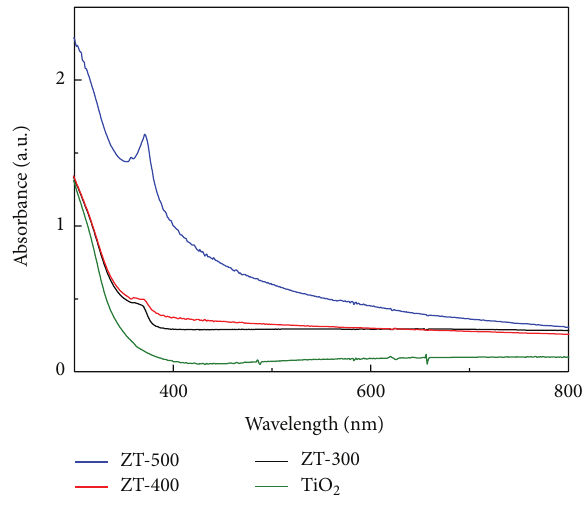
Figure 4: UV-vis absorbance spectra of ZT-300, ZT-400, ZT-500, and TiO 2